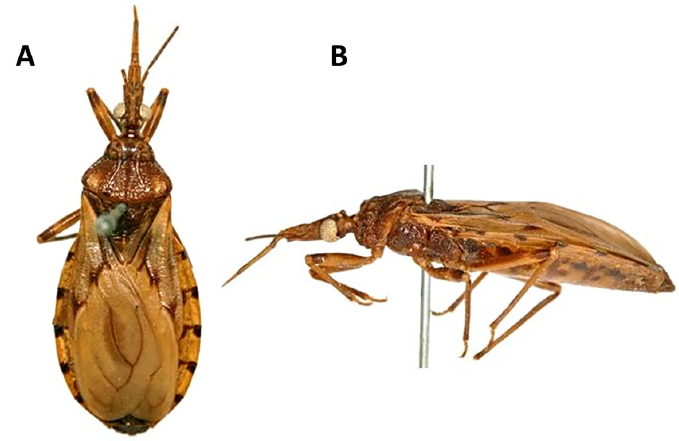
Figure 12. Holotype of T. sordida described by Stål in 1859 (as Conorhinus sordidus ) and deposited in the Zoologisches Museum, Berlim, Alemanha, A—Dorsal view; B—Lateral